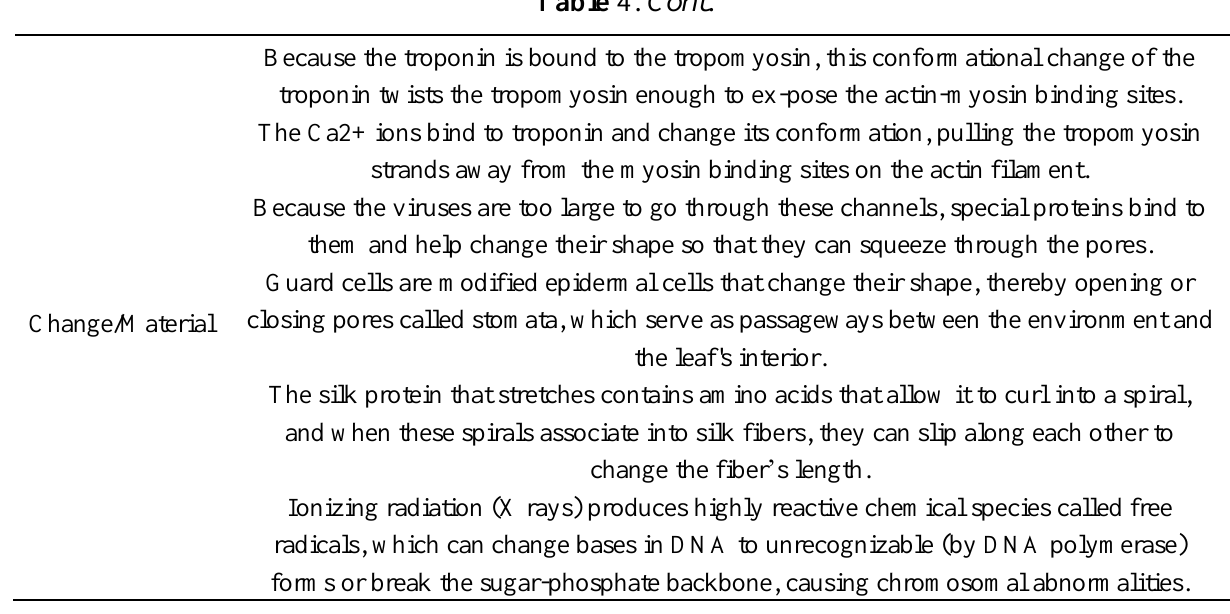
Table 5. Biological corpus results mapped to the function/flow pair detect chemical energy. Function/Flow Biological Corpus Results